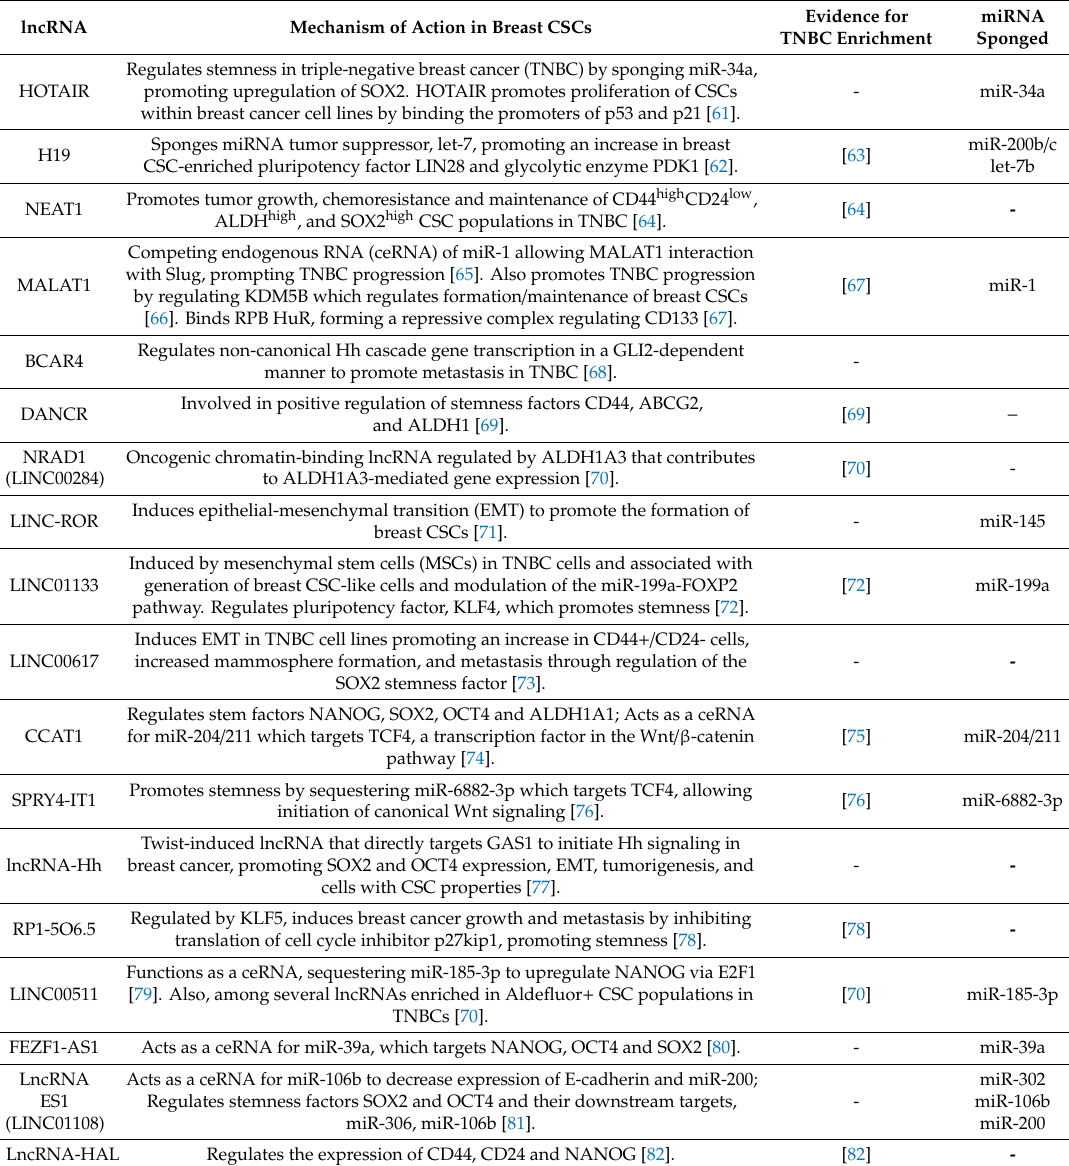
Table 1. Summary of long non-coding RNA (lncRNA) functions in breast cancer stem cells (CSCs). lncRNA Mechanism of Action in Breast